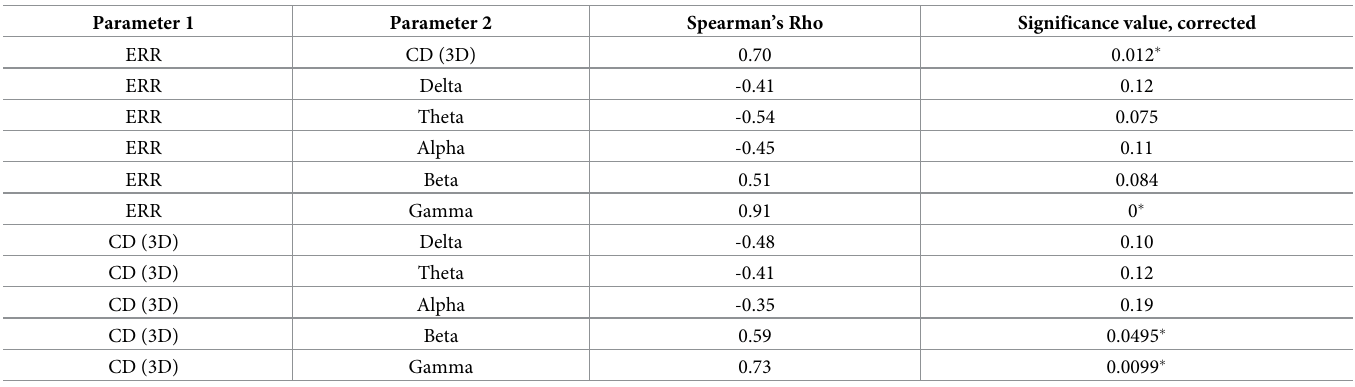
Table 5. Summary of correlations for measured changes before and after recovery of response